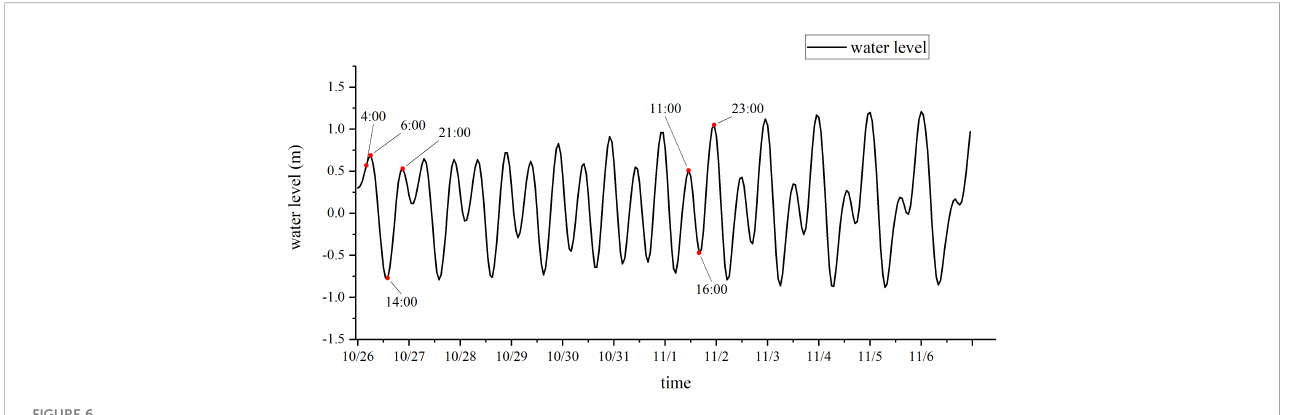
FIGURE 6 Water level variations during red